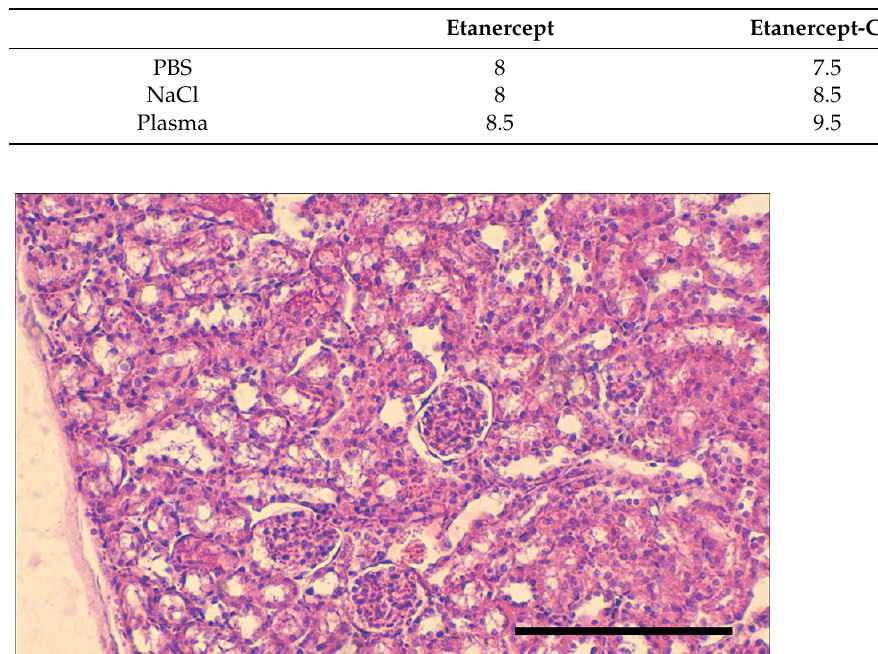
Figure A3. Acute inflammatory process in the renal tissue induced by injection of 20 µL of complete Freund ’ s adjuvant under the capsule of the left kidney (2.5 months after injection) ( A – D ): macrofocal leukocyte infiltrates as a response to the adjuvant action (1); epithelial dystrophy or tubular lumen occlusion (2); local accumulation of immune cells in the parenchyma (infiltrate) (3); vascular plethora (4); degeneration of glomerular capillaries, collapse of Bowman ’ s capsule (5); small foci of the renal parenchyma sclerosis (6); multicellularity and glomerular edema - a sign of inflammation, narrowing of the Bowman ’ s capsule lumen (7); renal tubules with signs of the epitheliumapical dystrophy (8). The thickness of the histological samples is 5 μm; dyes: hematoxylin and eosin. The scale bar is 200 µm.